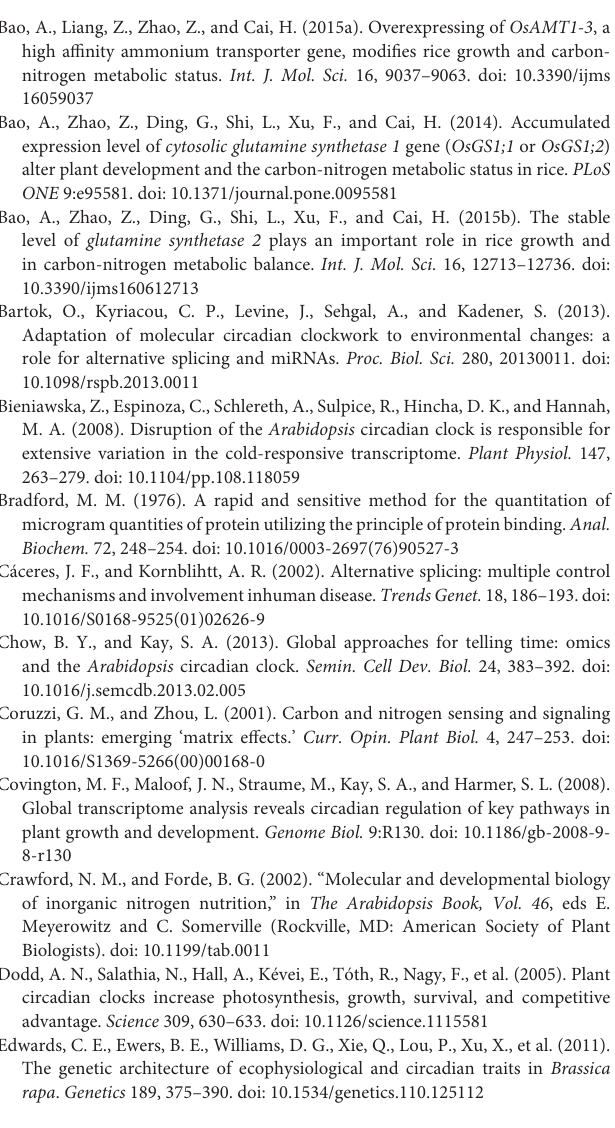
Supplementary Figure S1 | The diagram of rice germination, planting, and harvesting. Supplementary Figure S2 | The reads mapped to individual chromosome at the time of 2:00, 6:00, 10:00, 14:00, 18:00, and 22:00. Supplementary Figure S3 | Heatmap of the mapped genes at the time of 2:00, 6:00, 10:00, 14:00, 18:00, and 22:00. Supplementary Figure S4 | Functional categories of the mapped genes at the time of 2:00, 6:00, 10:00, 14:00, 18:00, and 22:00. Supplementary Figure S5 | The alternative splicing events at the time of 2:00, 6:00, 10:00, 14:00, 18:00, and 22:00. Supplementary Figure S6 | qRT-PCR analysis of nine randomly selected differentially expressed genes. Values are mean ± SD from three biological replicates. Supplementary Figure S7 | The size distribution of unique sRNA sequences.